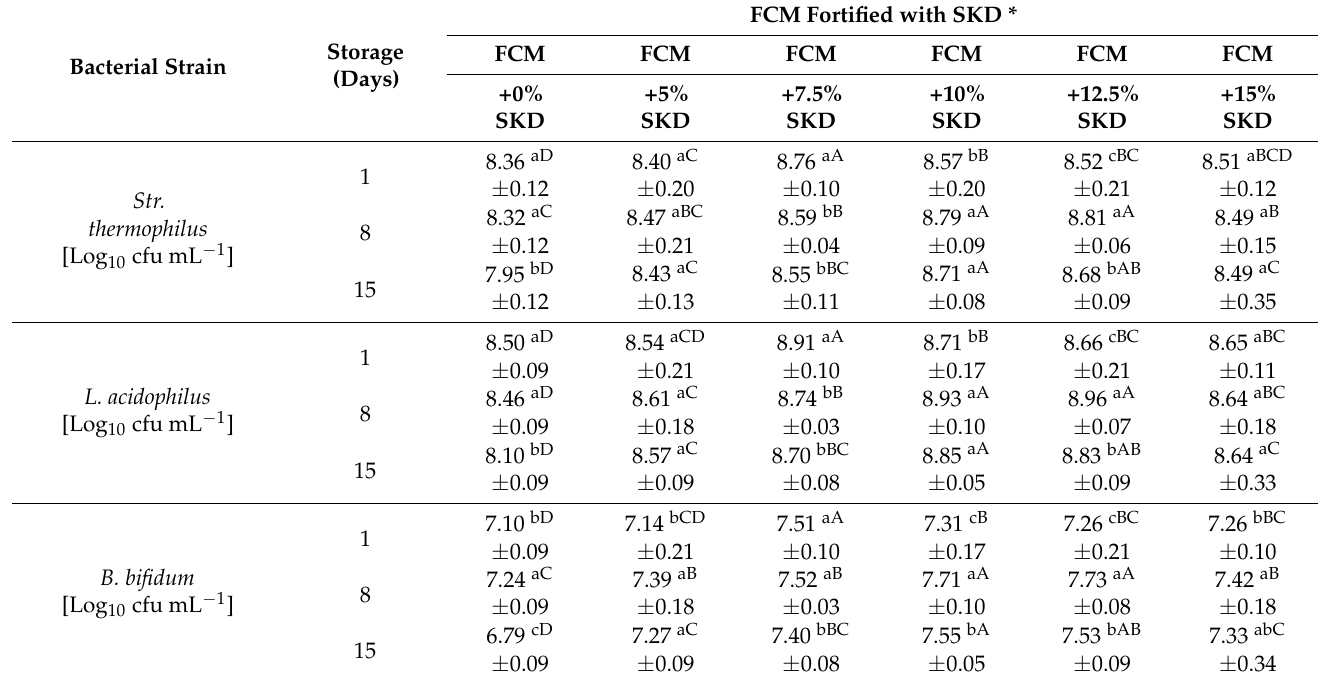
Table 6. Microbiological analysis of fermented camel milk (FCM) and FCM fortified with Sukkari